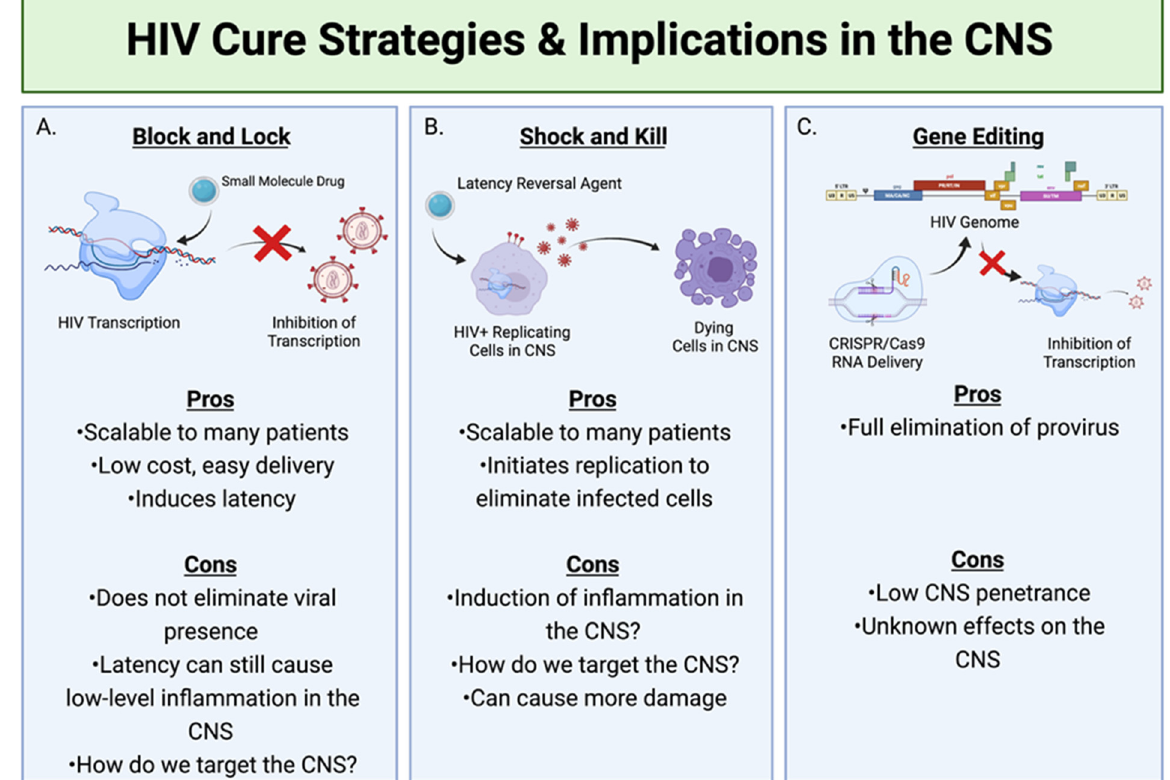
Figure 2. HIV cure strategies and their implications within the CNS. ( A ) Block and Lock involves the use of small molecule drugs to inhibit the transcription of the HIV genome, therefore stopping the formation of any new viral particles. ( B ) Shock and Kill utilizes latency reversal agents to activate HIV replication in latent cells, therefore making them targets for clearance by the immune system. ( C ) The utilization of CRISPR can deliver target RNA to the genome of infected cells harboring proviruses and eliminate these proviruses. Created with BioRender.com.